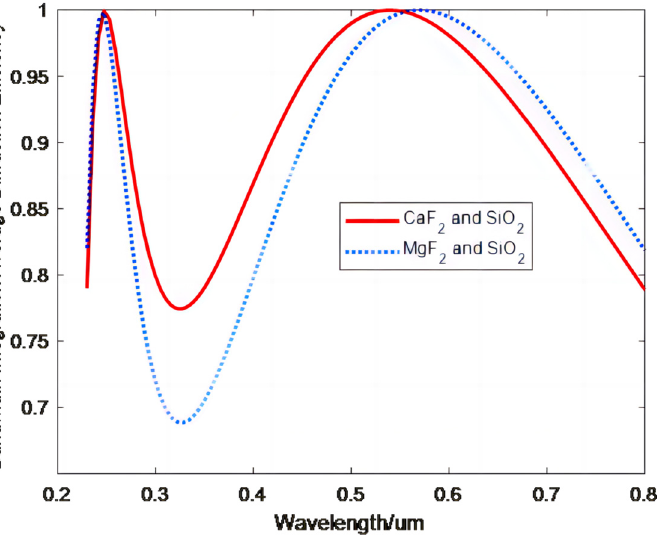
Figure 4. BIADE versus the wavelength after optimization of double-layer DOEs for substrates consisting of different material combinations.